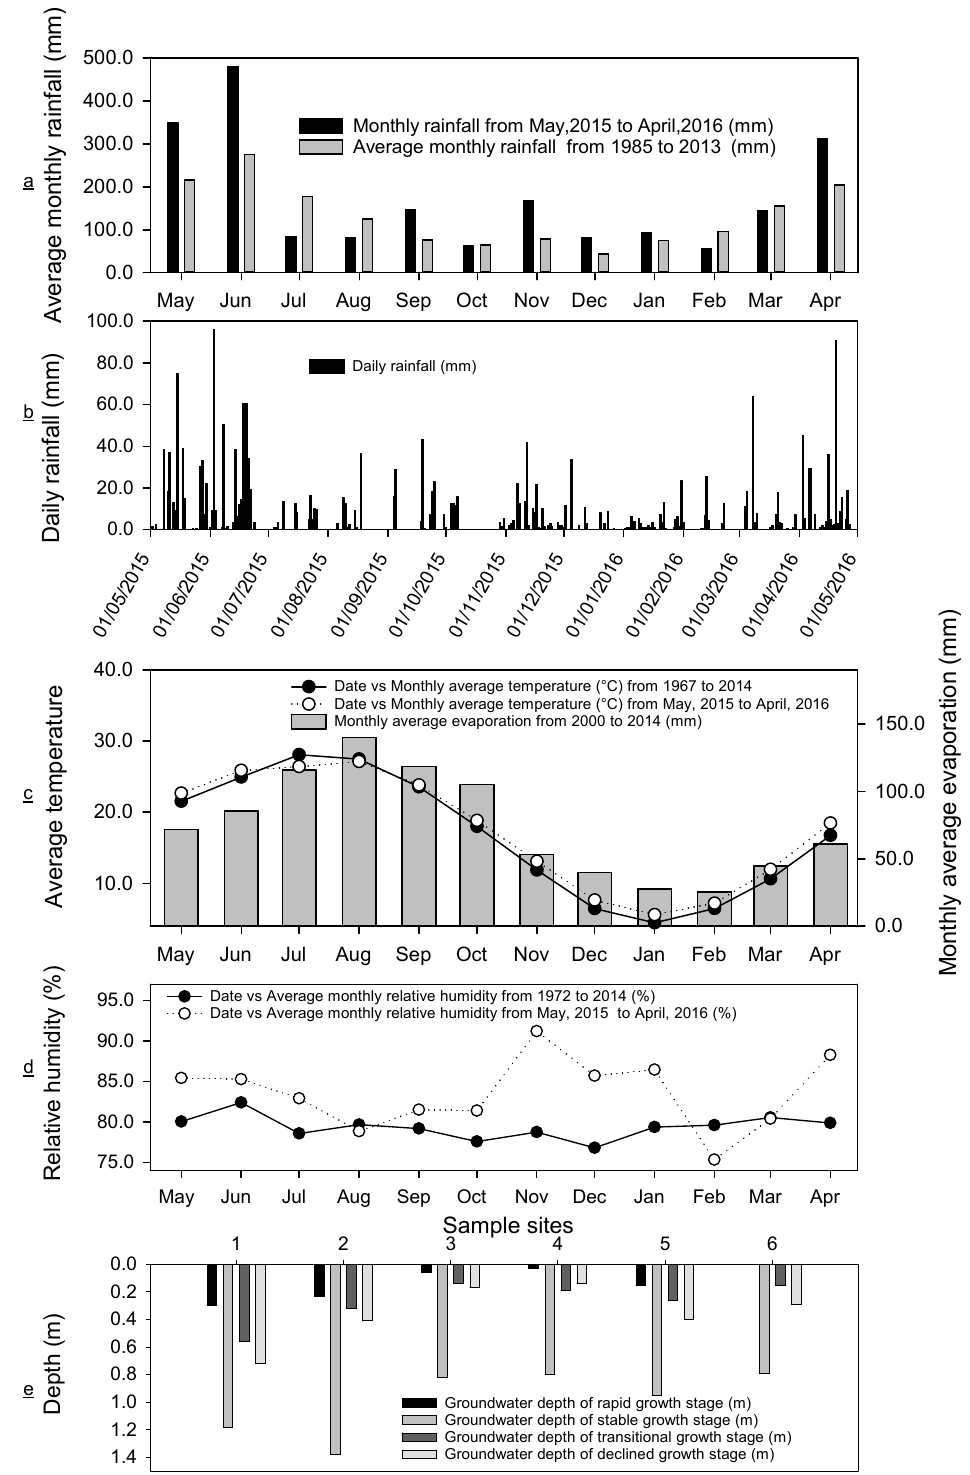
Figure 4. Hydrological and climatic characteristics. The air humidity data was from the weather station (XiuShui Station) closest to the sample points, so there would be some differences with the humidity data of sample points, but their trends should be